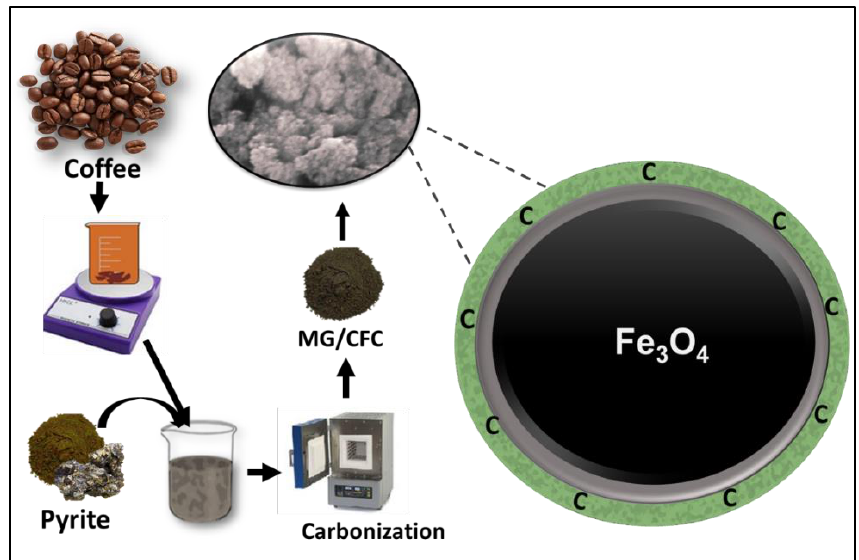
Figure 10. Schematic diagram for the synthesis of MG/CFC green composite from pyrite and coffee.